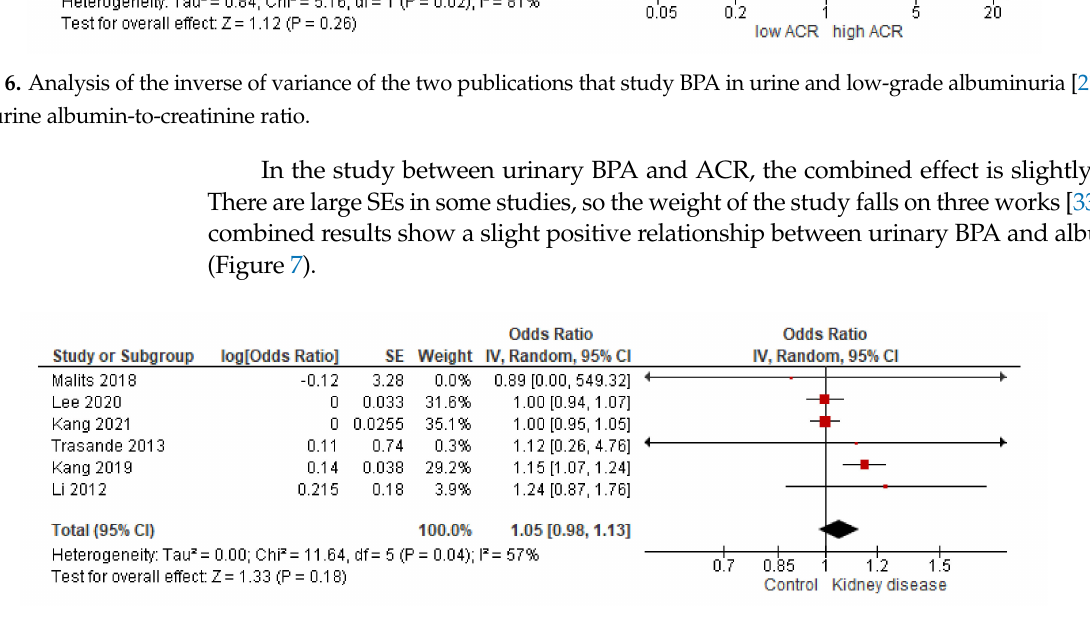
Figure 7. Analysis of the inverse variance of the publications that study BPA in urine and ACR [21,32–34,36].